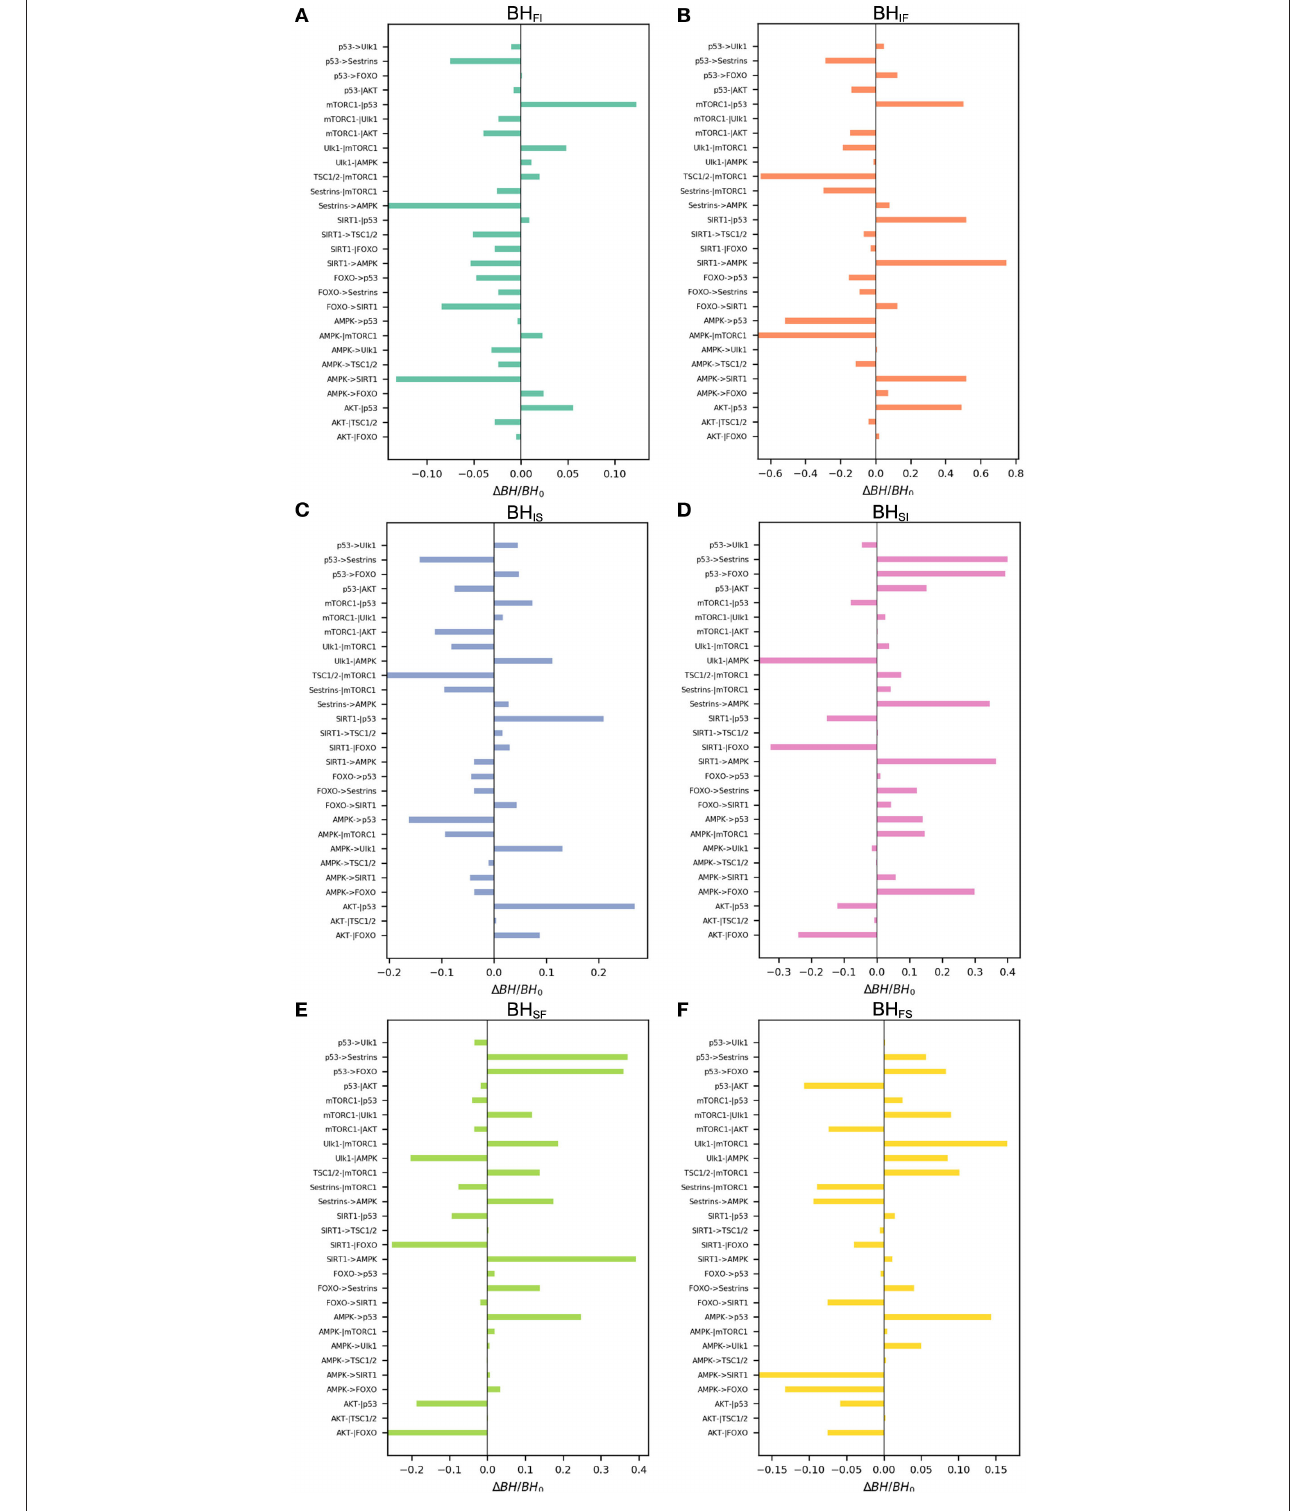
FIGURE 6 | Global sensitivity analysis of the barrier height upon changing regulatory strengths. BH 0 , barrier height with the original value; 1 BH , change in barrier height upon changing the regulation. (A) Change in barrier height from the fast-aging to the intermediate attractor. (B) Change in barrier height from the intermediate to the fast-aging attractor. (C) Change in barrier height from the intermediate to the slow-aging attractor. (D) Change in barrier height from the slow-aging to the intermediate attractor. (E) Change in barrier height from the slow-aging to the fast-aging attractor. (F) Change in barrier height from the fast-aging to the slow-aging